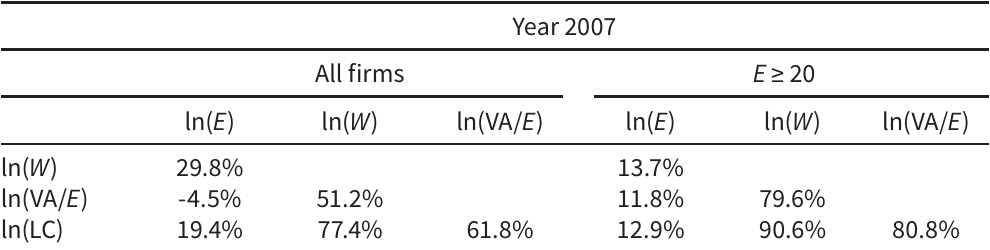
Correlations between log size, log firm wage and log labor